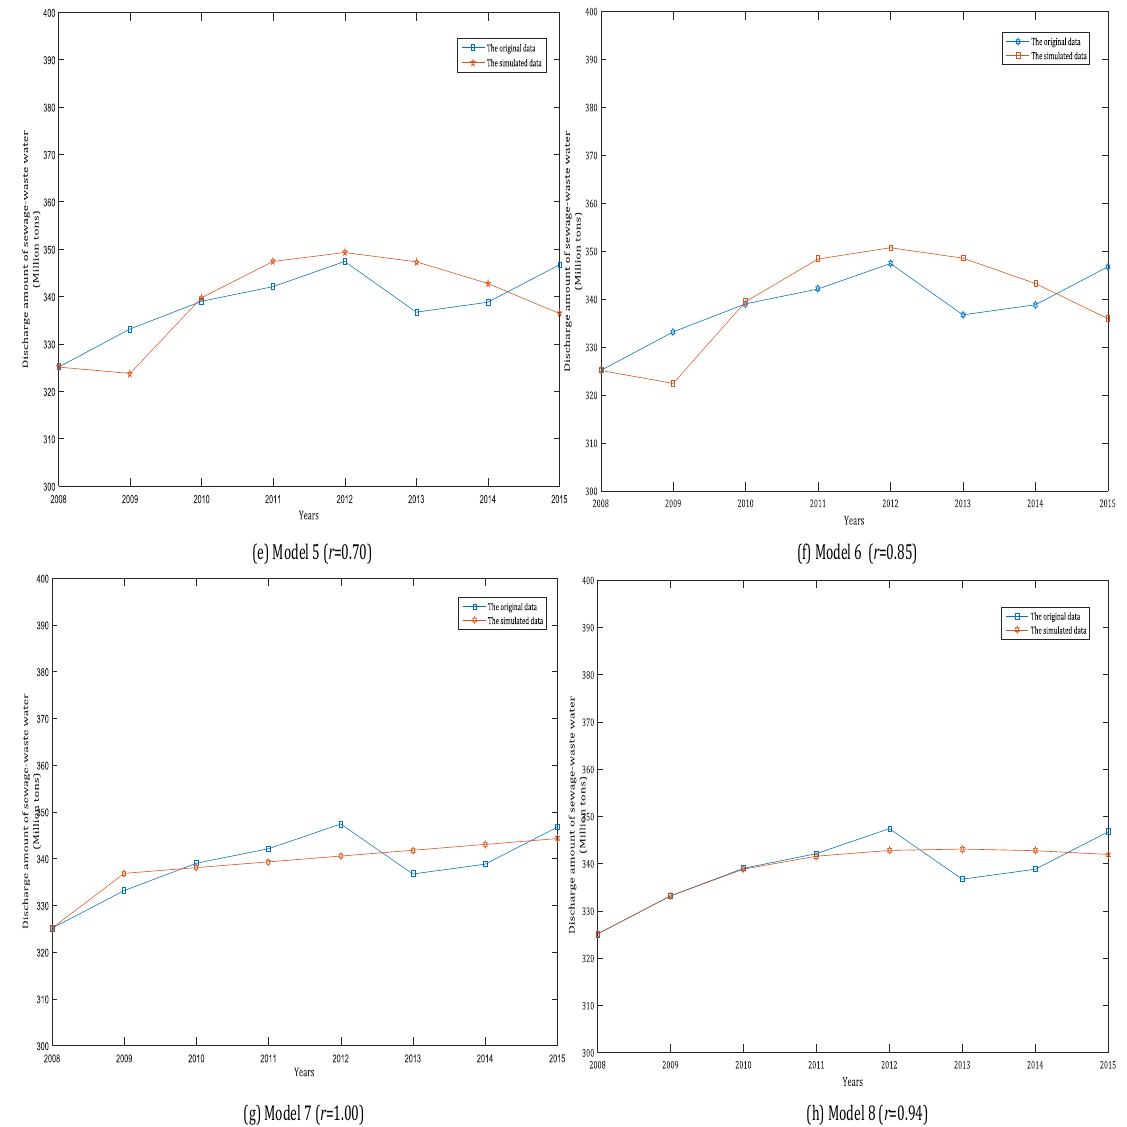
Figure1. Simulated curves of the DWSGM(1,1)model with different orders. Figure 1. Simulated curves of the DWSGM (1,1) model with different